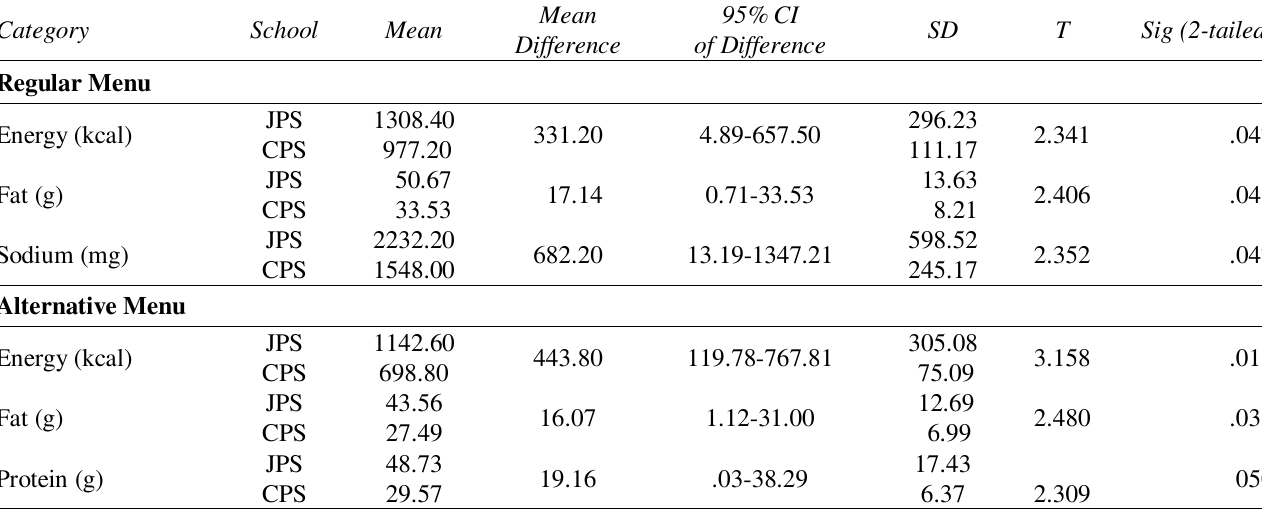
Table 6: Differences between nutrient intake between regular meals and alternative meals in Jackson and Canton Schools